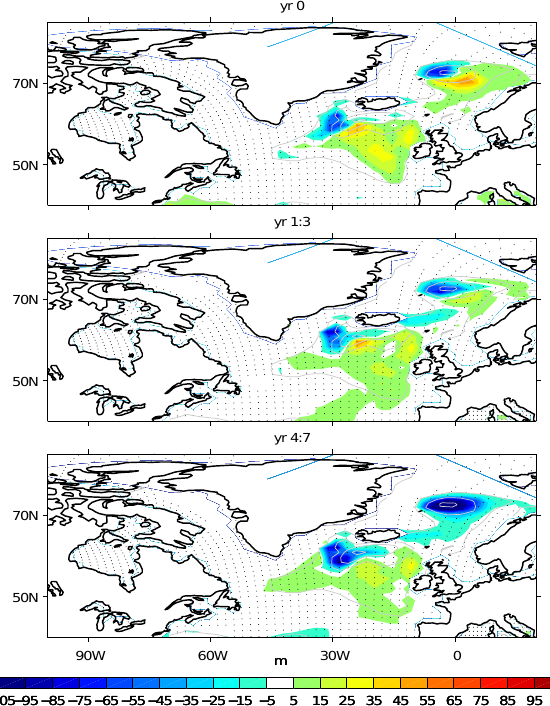
Fig. 17. Composites of anomalous March mixed layer depth in response to volcanic eruptions occurring during the period 1100– 1300. The composite is shown for the year of the eruption (left), averaged over the following 3 years (middle), and averaged 4 to 7 years later (right). Grey lines show the annual mean mixed layer depth field in the model, with a contour interval of 500m. Dotted areas are not significant at the 5% level.